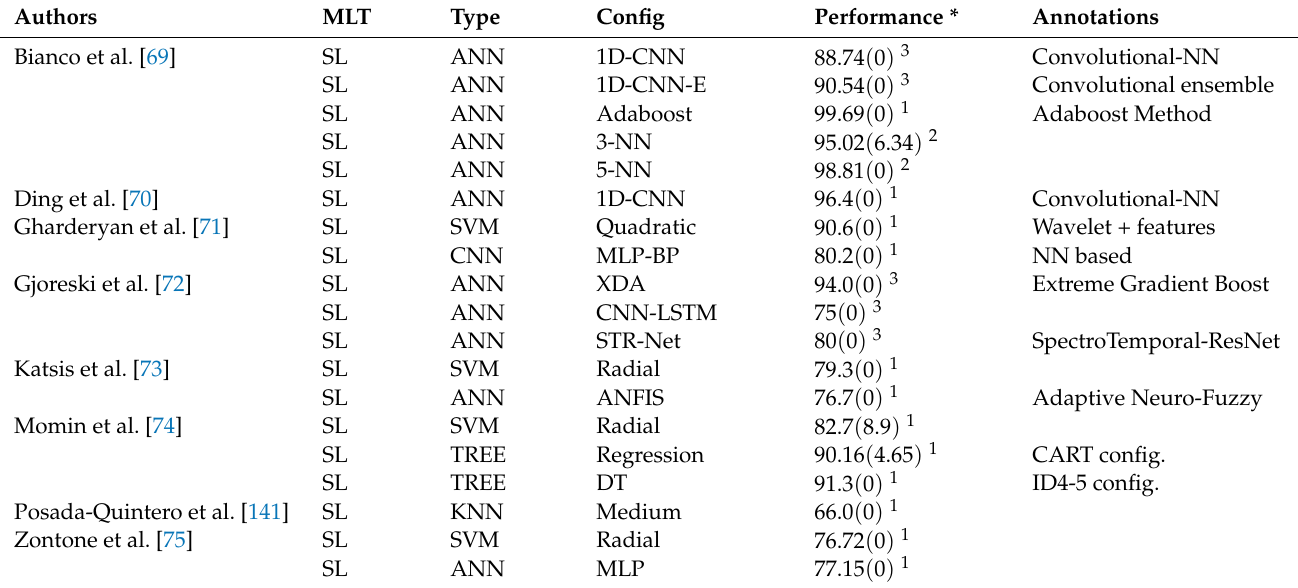
Table 15. Supervised learning methods for task-oriented applications.